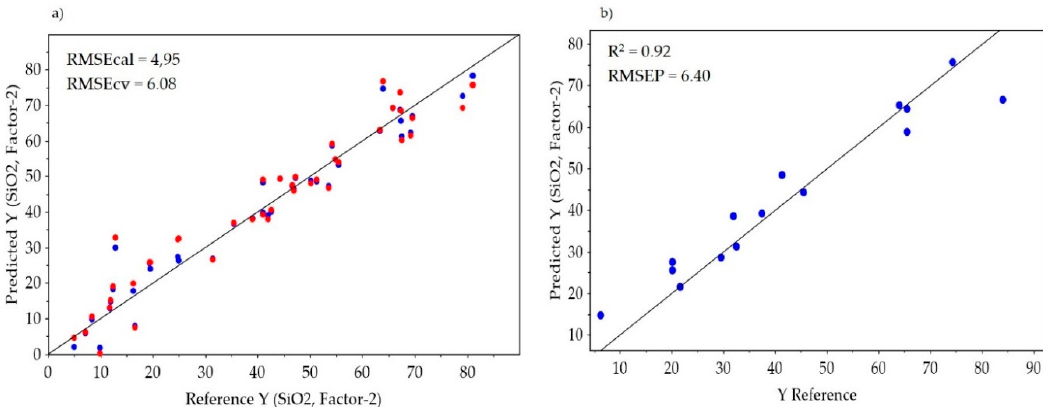
Figure 7. PLS regression of predicted vs. actual SiO 2 concentration after the selected features fusion of the normalised MWIR and LWIR data blocks ( a ) for calibration and cross-validation; and in ( b ) the prediction